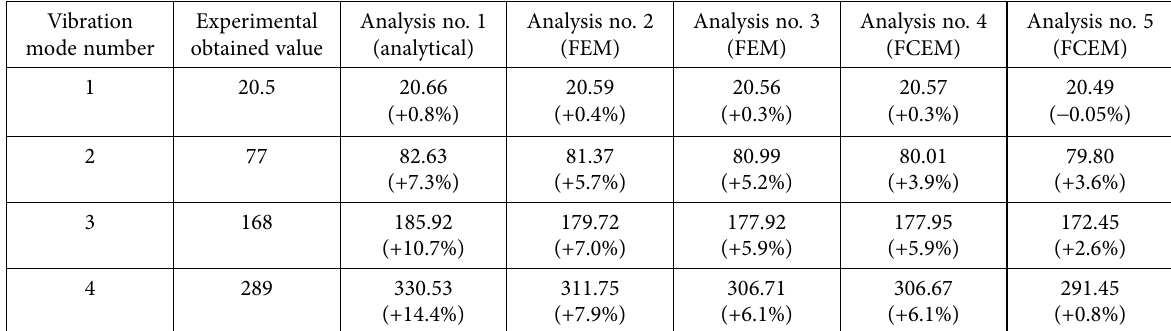
Table 2. Natural frequency values (Hz) obtained with different methods for the studied concrete beam problem, and the corresponding error percentage to the obtained experimental value Vibration mode